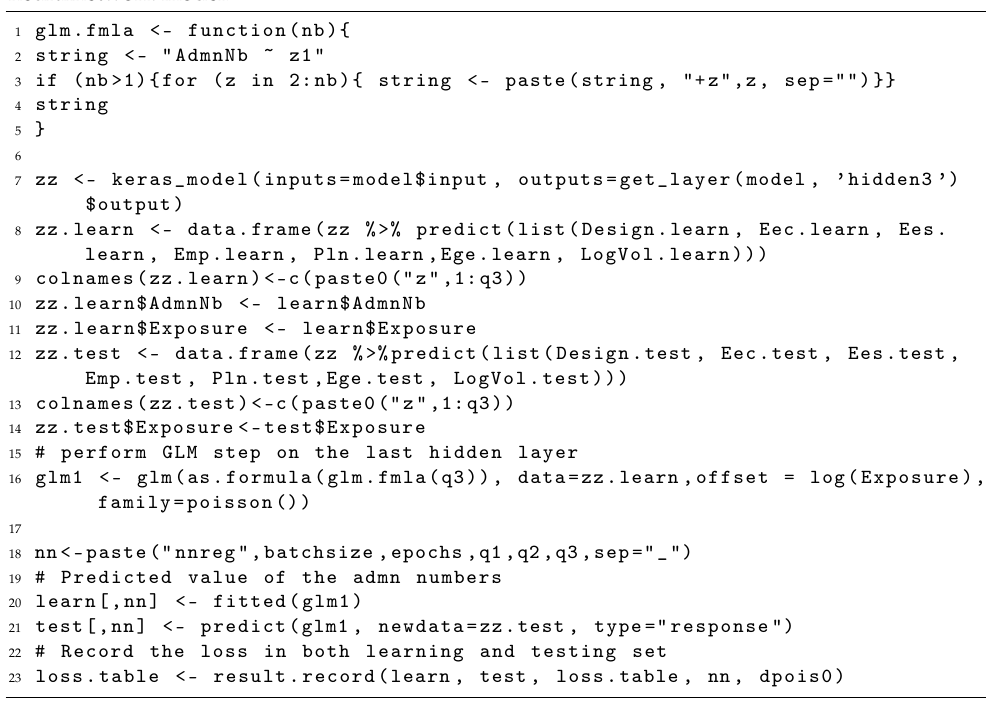
23 loss.table <- result.record(learn , test , loss.table , nn,